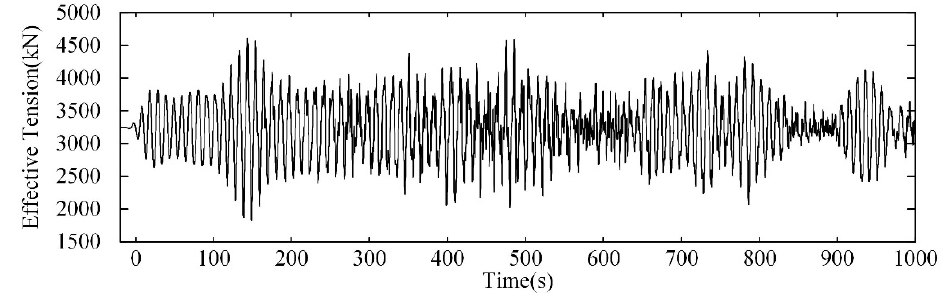
Figure 7. Time histories for the flexible pipeline top tension.